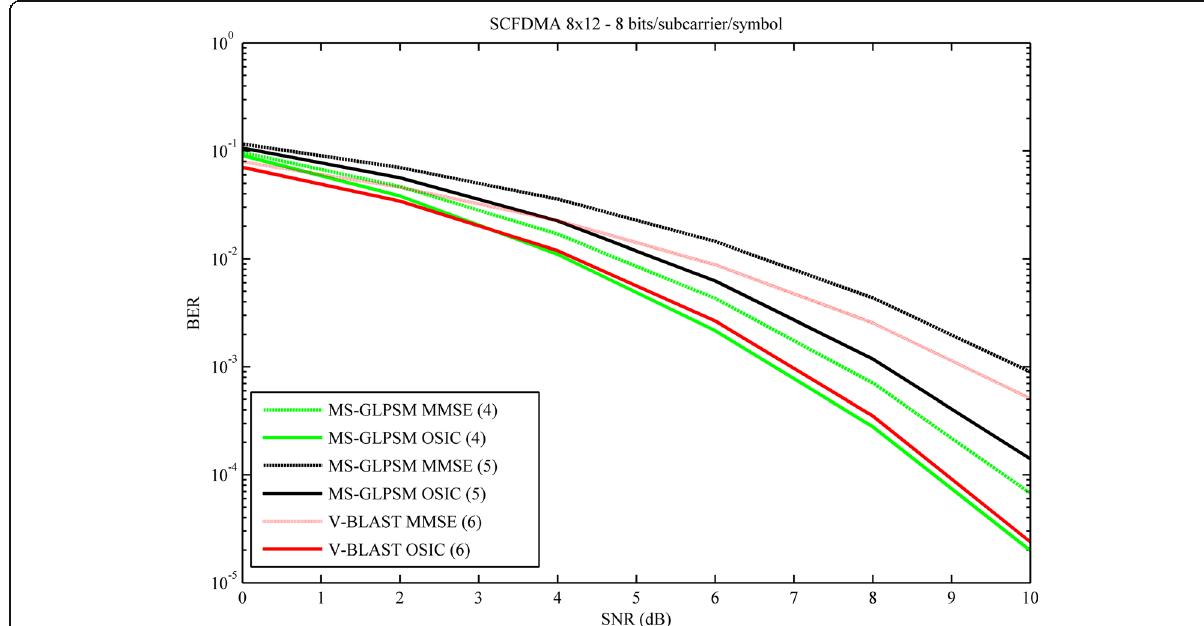
Fig. 6 Performance comparison for MS-GLPSM and V-BLAST for MMSE and OSIC receivers. As the significant performance gain in the cases of multiple streams can be achieved using OSIC receiver, the performance comparison is given for MS-GLPSM SC-FDMA and V-BLAST SC-FDMA when MMSE or OSIC receivers are used. The cases of two and four streams are presented for MS-GLPSM. All parameters are given in Table 1. Channel model is ETU-70